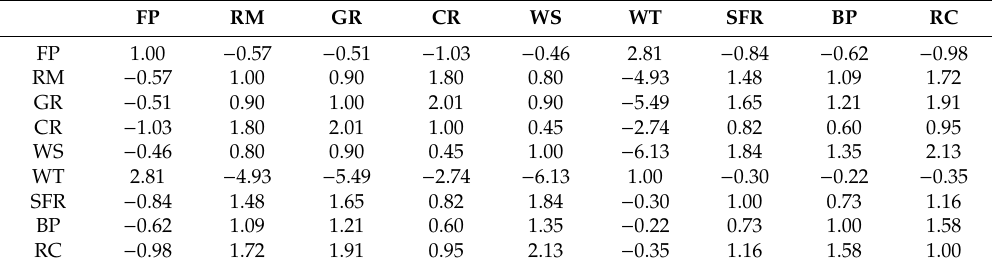
Table 9. Ecosystem services trade-o ff degrees in Jiangxi province from 1995 to 2000.